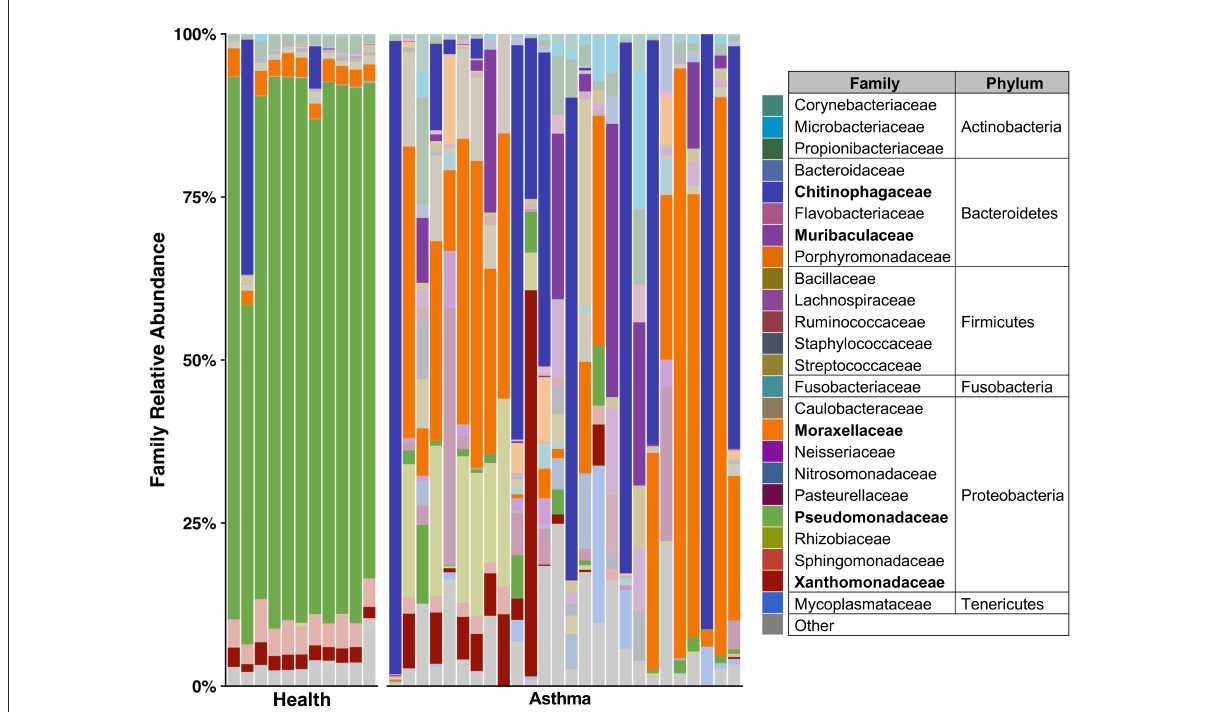
FIGURE3 Taxa present in bronchoalveolar lavage fluid—mean relative abundance of taxa present at > 5% in bronchoalveolar lavage fluid collected from healthy and cats with spontaneous asthma. Families with a relative abundance of < 5% are grouped into “Other.” Families with > 40% relative abundance in at least one sample are bolded in the legend and represented by a darker color in the